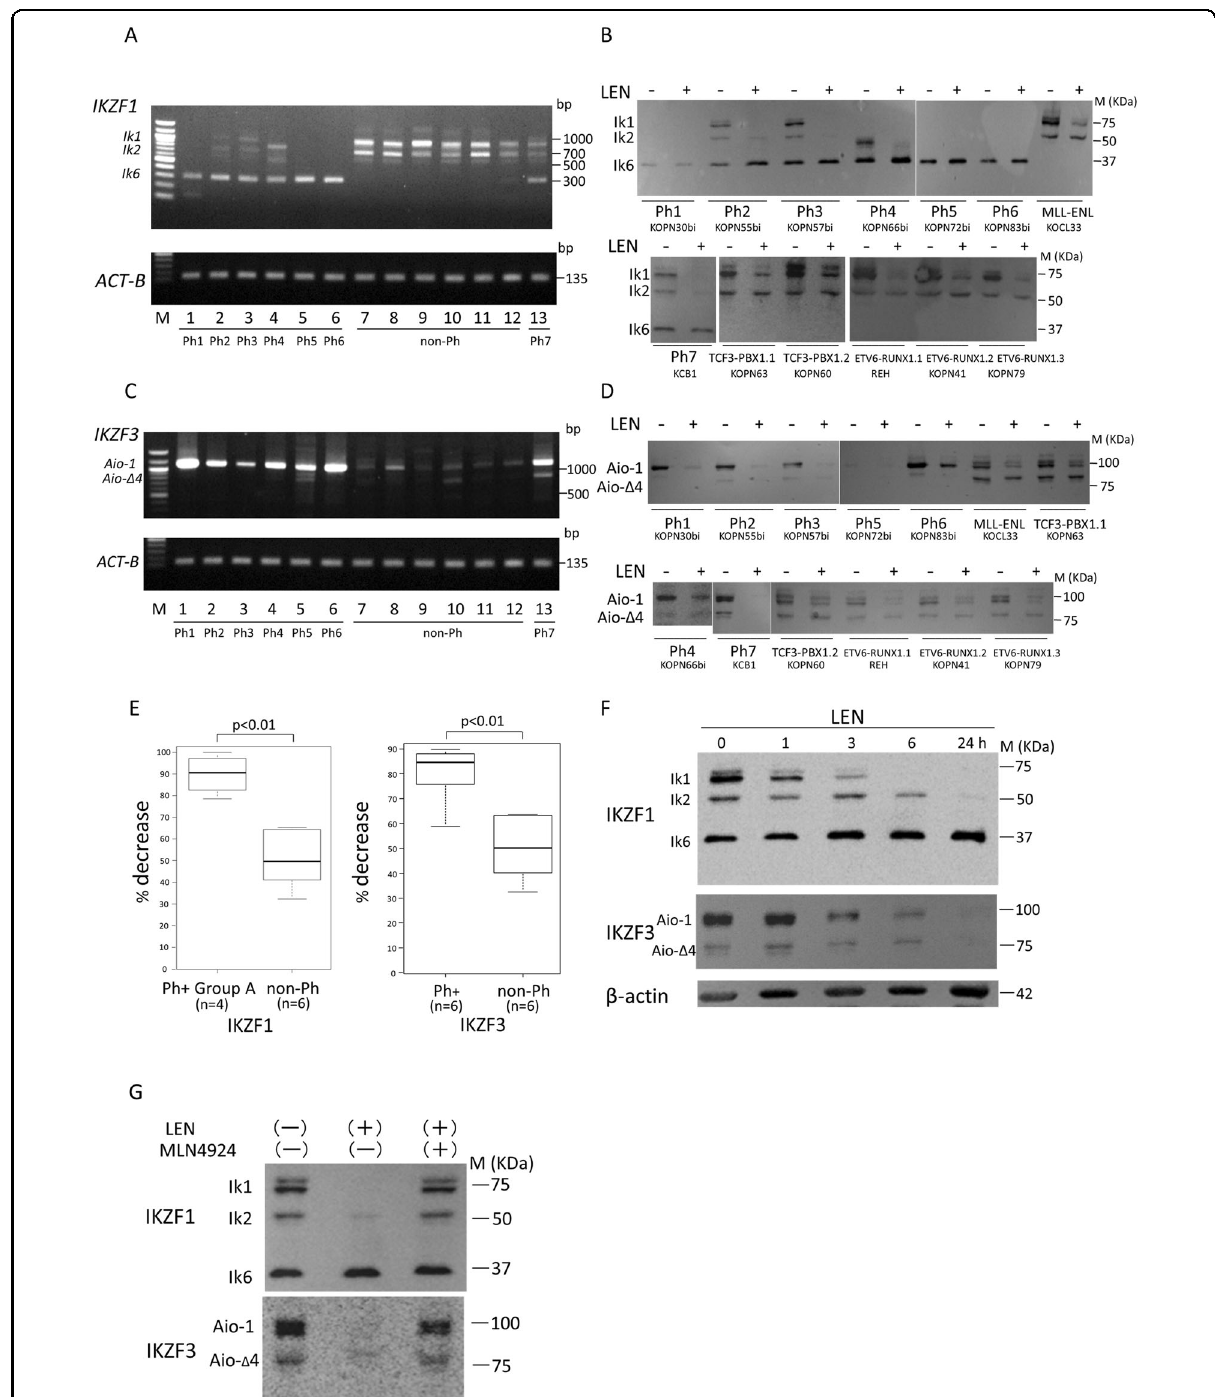
Fig. 1 (See legend on next